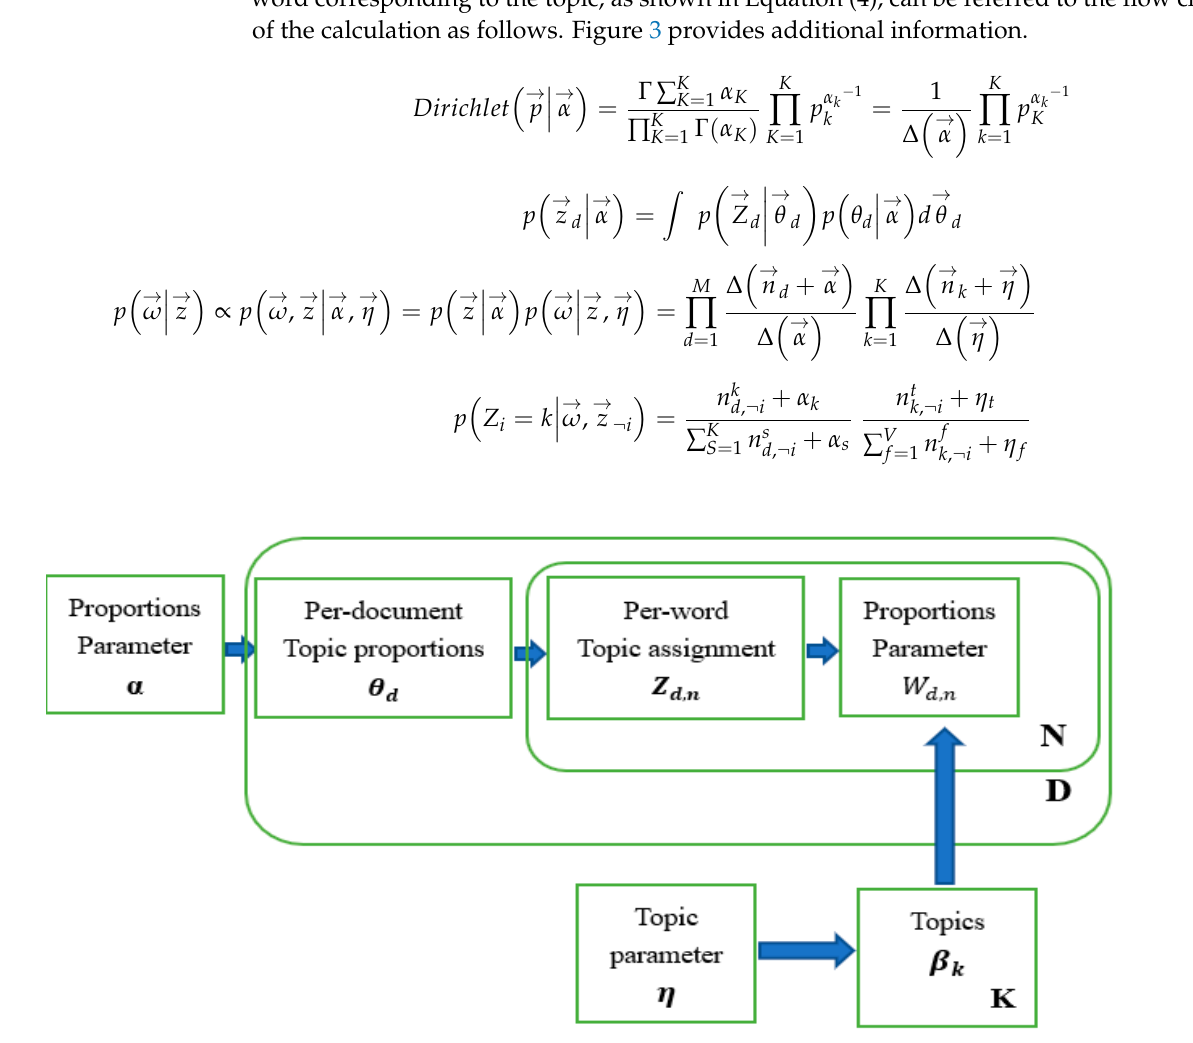
Figure 3. Establishment of PMC Index System.